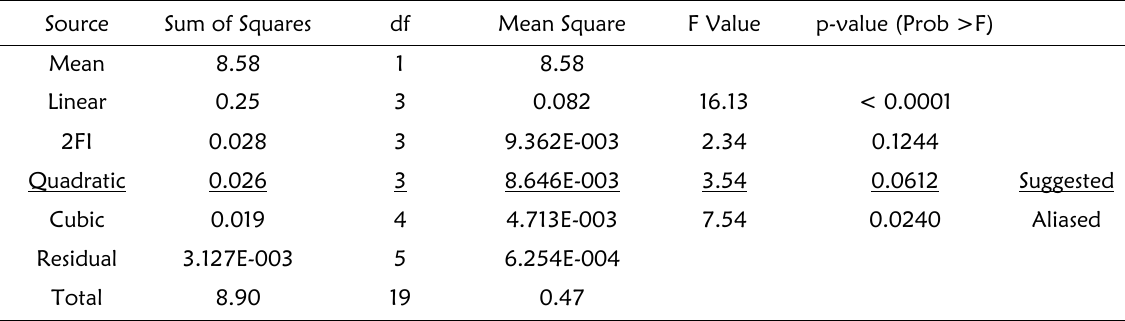
Table 7: Fit summary statistics for coefficient of